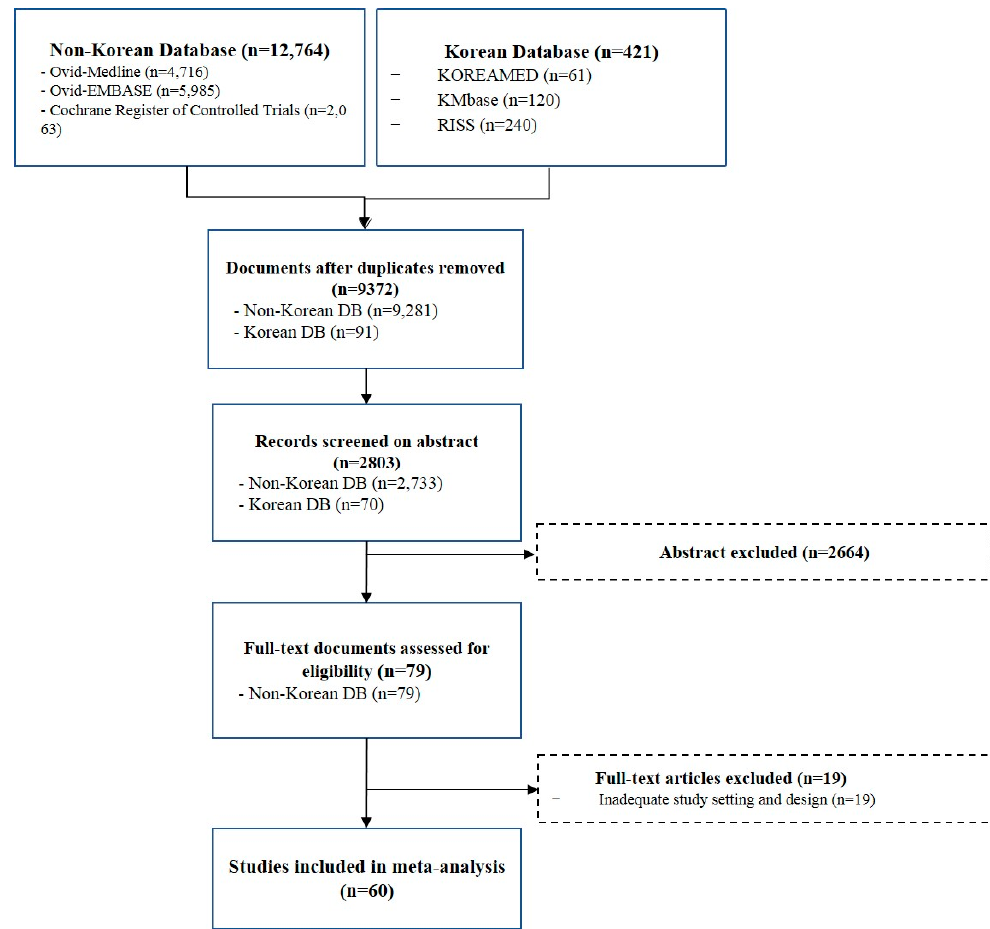
Figure 1. Flowchart of study selection for the systematic review and meta-analysis.